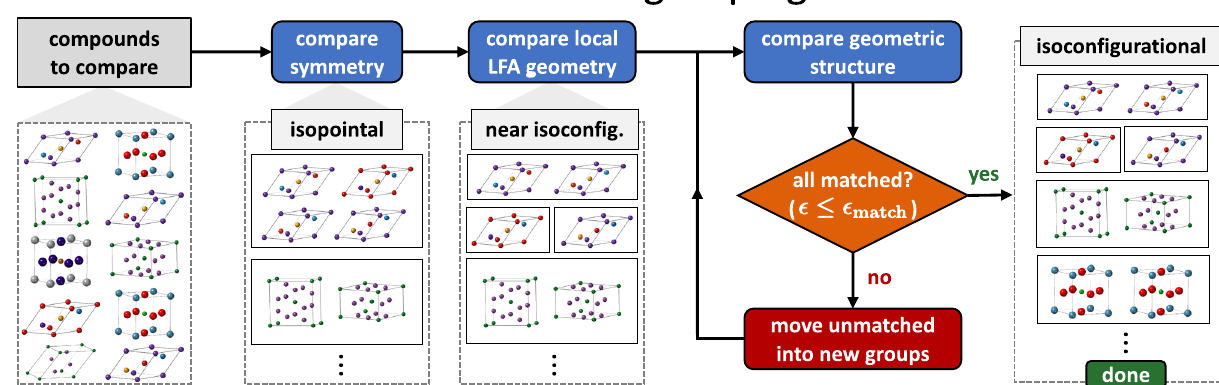
Fig. 4 Automatic grouping of multiple compounds. Compounds are compared in the following sequence: symmetry, local LFA geometry, and geometric structure. The algorithms determine isopointal, near isocon fi gurational, and isocon fi gurational structures, respectively, and aggregate them into similar sets (enclosed in black solid-lined boxes). Unmatched structures (i.e. ϵ > ϵ match ) after the initial geometric structure comparison are put into new groups and re-compared until all equivalent structures are grouped. This sequence is the same for material-, structure-, decoration-, and magnetic-type comparisons; however, the criteria for atom mappings differ (see subsection ” Super-type comparisons ” for details). The symmetry, local LFA geometry, and geometric structure comparisons (blue boxes) are multithreaded for parallel